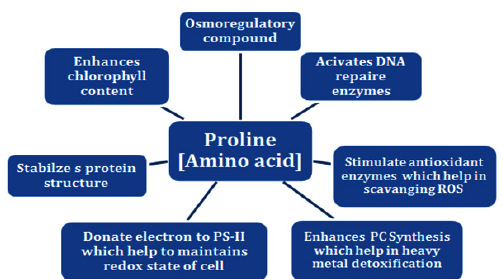
Fig. 2. Production of ROS in various kind of stress (Source: Adopted from Das and Roychoudhury, 2014)